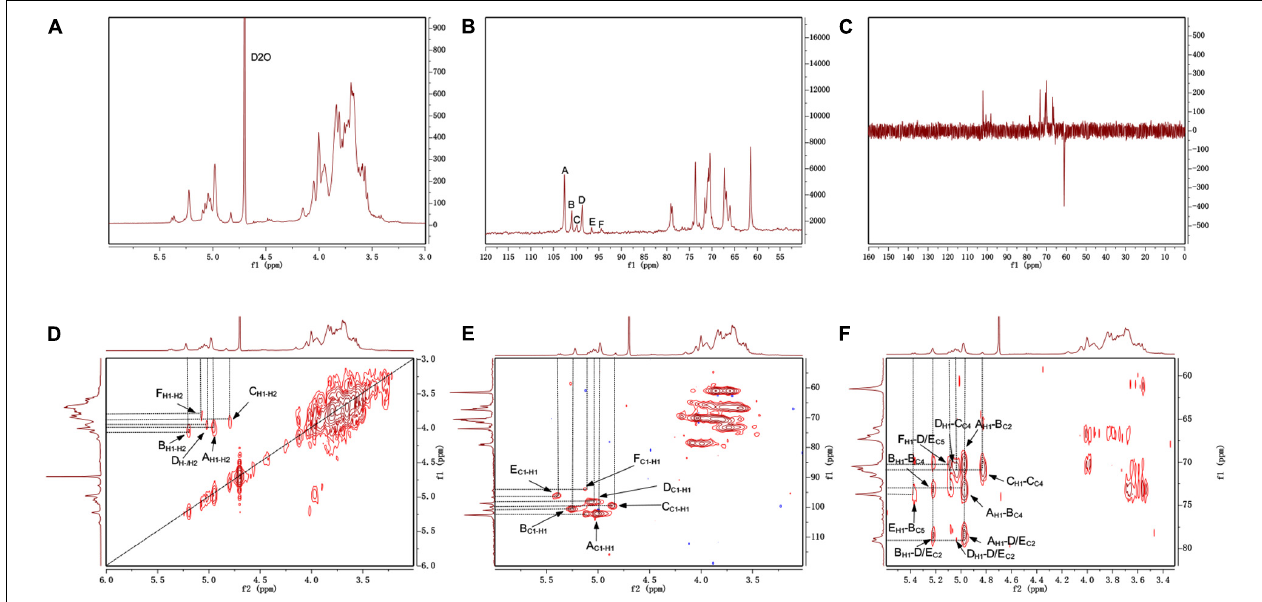
FIGURE 4 | The NMR spectrum of S-EPS 2-1 in D 2 O. (A) 1 H; (B) 13 C; (C) DEPT-135; (D) 1 H- 1 H COSY; (E) HSQC; (F) HMBC.